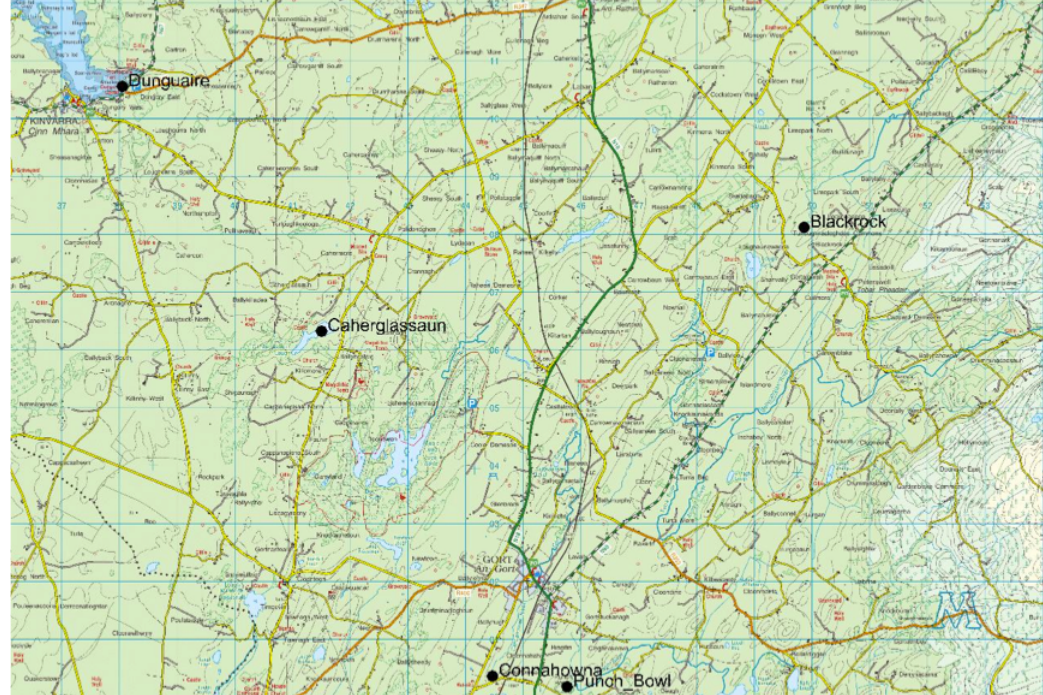
Figure 3: Field Trip stops. 1. Blackrock, 2. Punch bowel, 3. Connahowna, 4. Caherglassaun and 5. Dunguaire castle Kinvarra. Insert map of Ireland slows location of the study